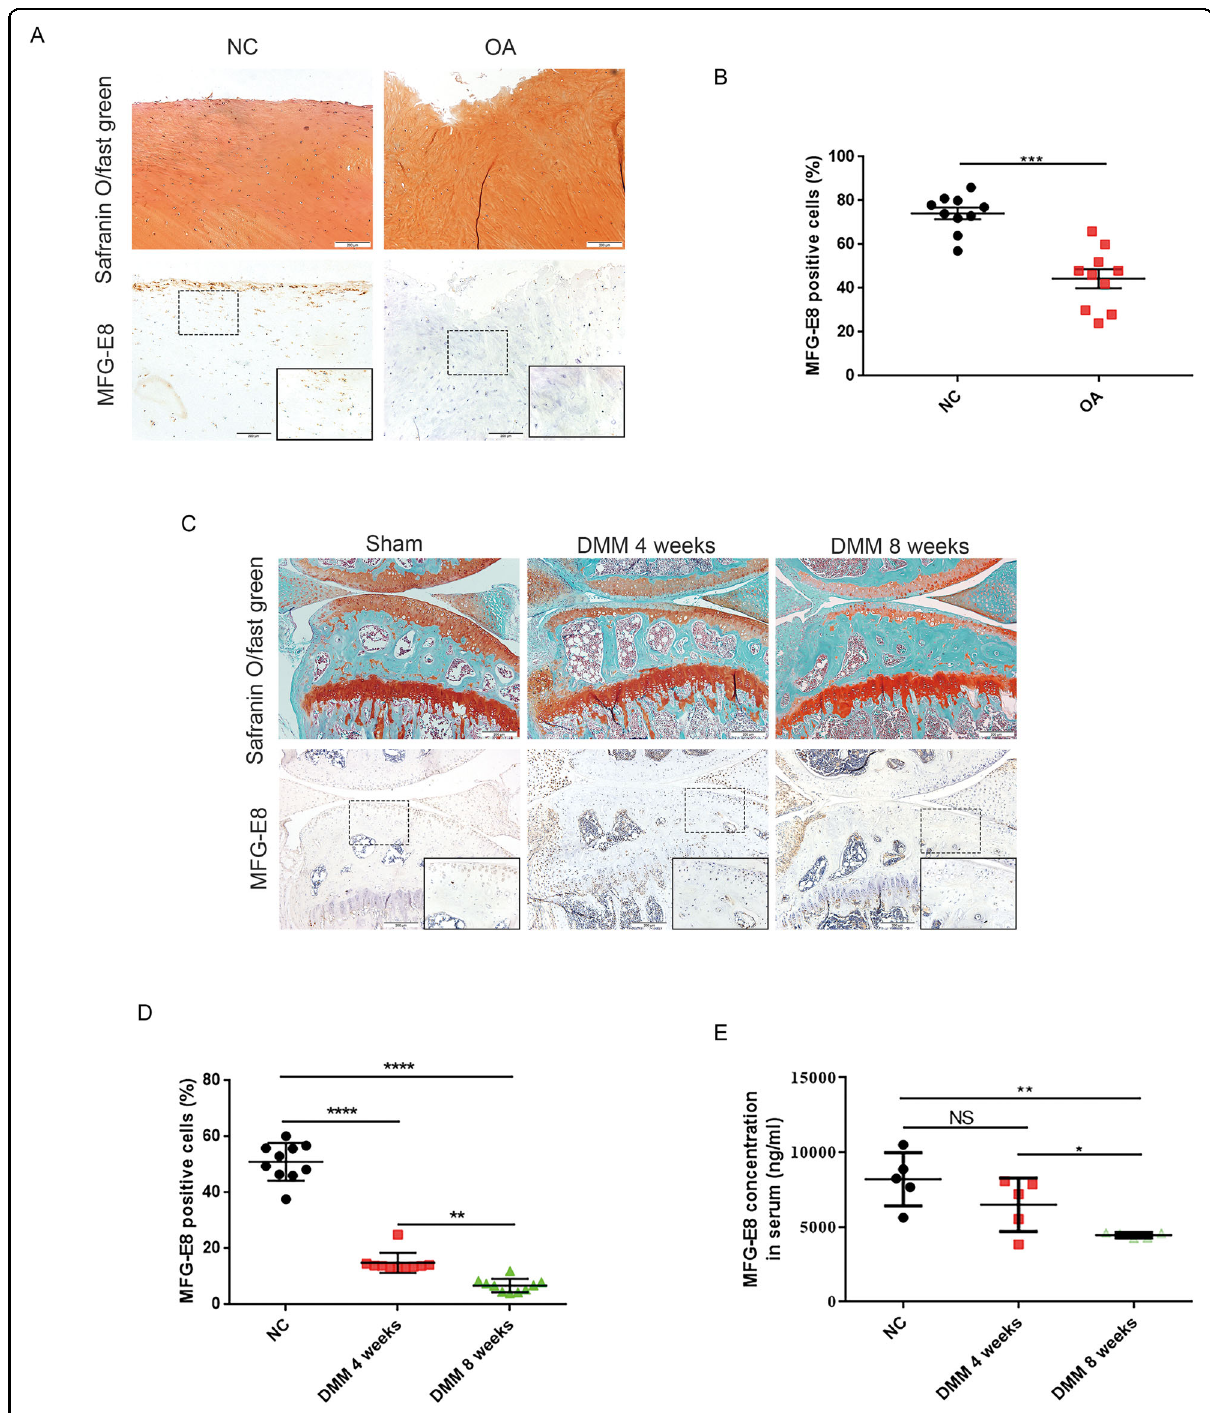
Fig. 1 Loss of MFG-E8-expressing chondrocytes and synoviocytes in patients with OA and OA mice. A Safranin O and Fast Green staining (upper) and immunostaining of MFG-E8 (lower) of human articular cartilage from medial (OA) and lateral (NC) tibial plateau of OA patients undergoing total knee arthroplasty. Scale bar: 200 µm; B Quanti fi cation of MFG-E8 in human articular cartilage of medial and lateral tibial plateau. n = 10 per group; C Safranin O and Fast Green staining (upper) and immunostaining of MFG-E8 (lower) of sagittal sections of knees from controls and OA model mice at 4 weeks and 8 weeks post destabilization of the medial meniscus (DMM) operations. Scale bar: 200 µm; D Quanti fi cation of MFG-E8 in articular cartilage of sham and DMM mice. n = 10 per group; E Enzyme-linked immunosorbent assay (ELISA) of MFG-E8 in serum of controls and OA model mice at 4 weeks and 8 weeks post OA surgery. n = 5 per group; * P < 0.05, ** P < 0.01, *** P < 0.001, **** P < 0.0001, ns not signi fi